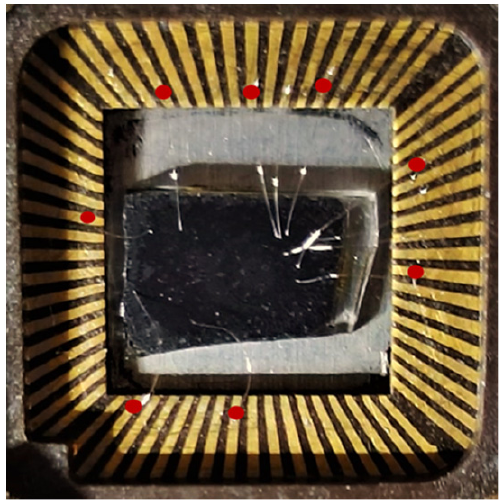
Figure 1. GL film on glass substrate glued onto chip carrier. All electrical connections between the sample and the chip holder (red filled circles) were made by Al wires with a bonding machine.